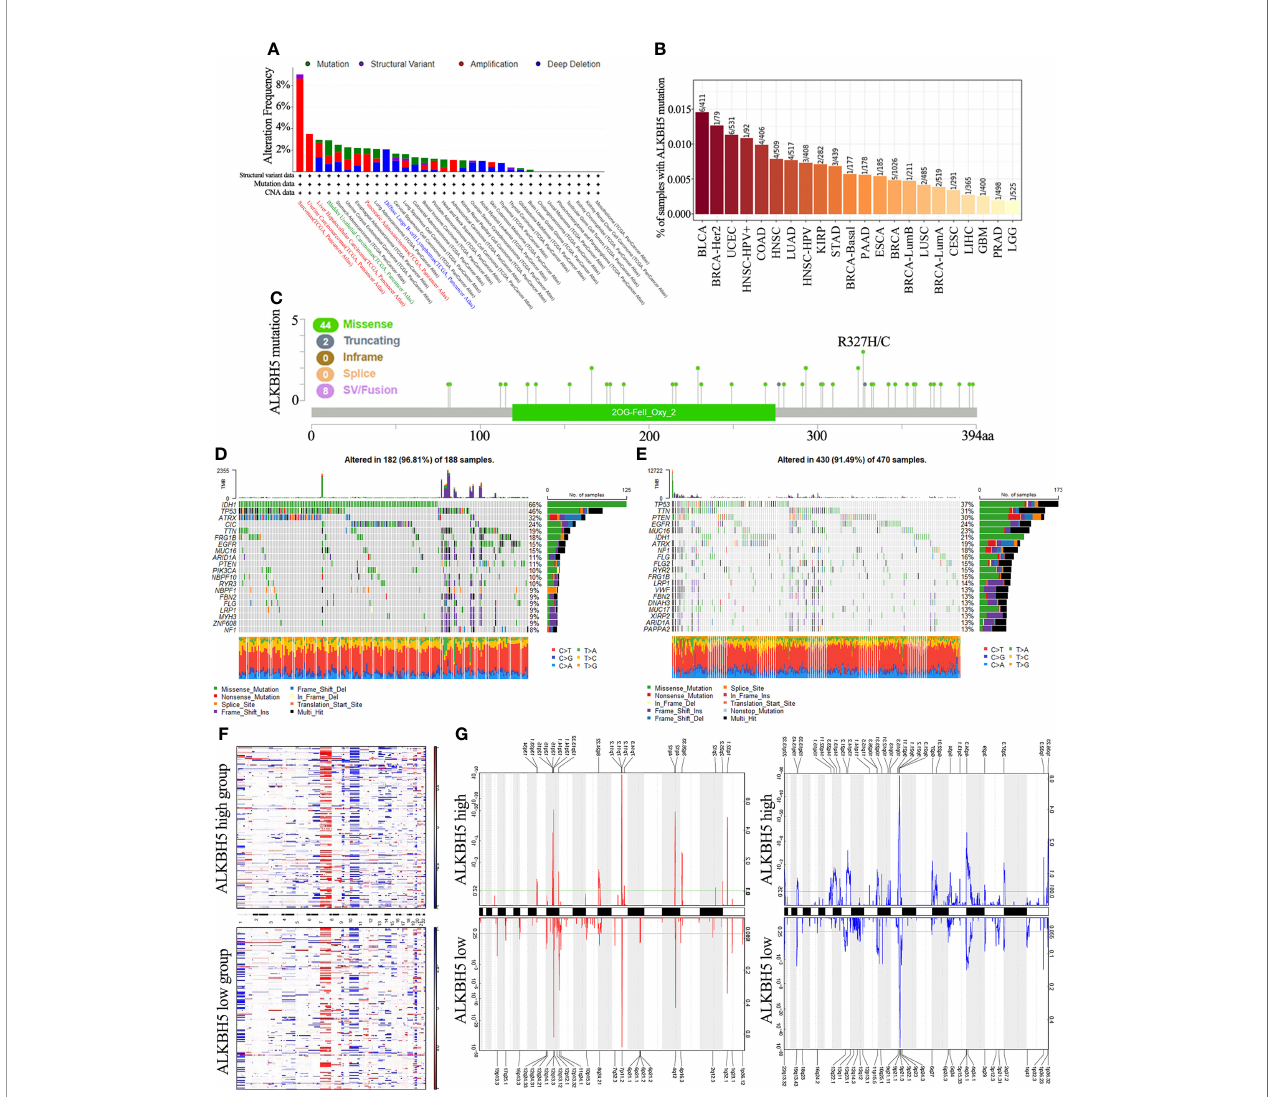
FIGURE 3 | Distinct genomic pro fi les associated with ALKBH5 expression and integrative analysis of complex cancer genomics and clinical pro fi les. (A) Genetic alteration features (Mutation, Structural Variant, Ampli fi cation and Deep Deletion) of ALKBH5 in 32 different tumors were analyzed in TCGA database by the cBioPortal tool. The red label represented the tumors with the top 3 levels of ampli fi cation. The green label represented the tumor with the highest mutation level and the blue label represented the tumor with the highest deep deletion level; (B) Mutation rates of ALKBH5 gene in various tumors via TIMER portal; (C) The mutation sites of ALKBH5 in multiple tumors by the cBioPortal tool. Detection of differential somatic mutations in gliomas, including 25% ALKBH5low group (D) and 25% ALKBH5high group (E) . Only the top 20 genes with the highest mutation rates were shown; (F) The CNAs pro fi le analysis about 25% ALKBH5low group and 25% ALKBH5high group in TCGA dataset via GISTIC2.0; (G) Frequency of ampli fi cations and deletions in gliomas with low and high ALKBH5 expression (Blue, deletion; red, ampli fi